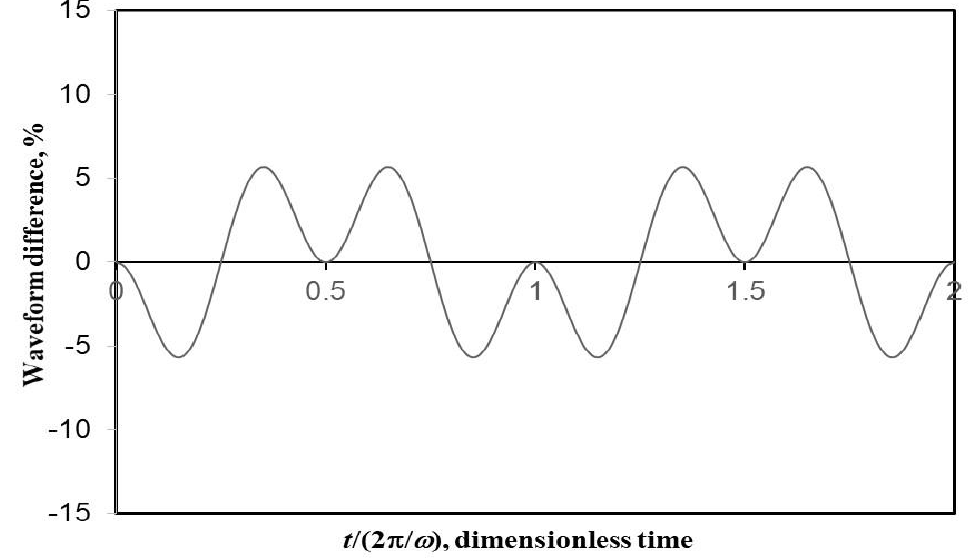
Figure 9. Difference between elliptic cosine and simple cosine ( c/a = 0.5, k = 5, w/w o = 3, ξ = 0.02, single cavity, nonlinear solution).